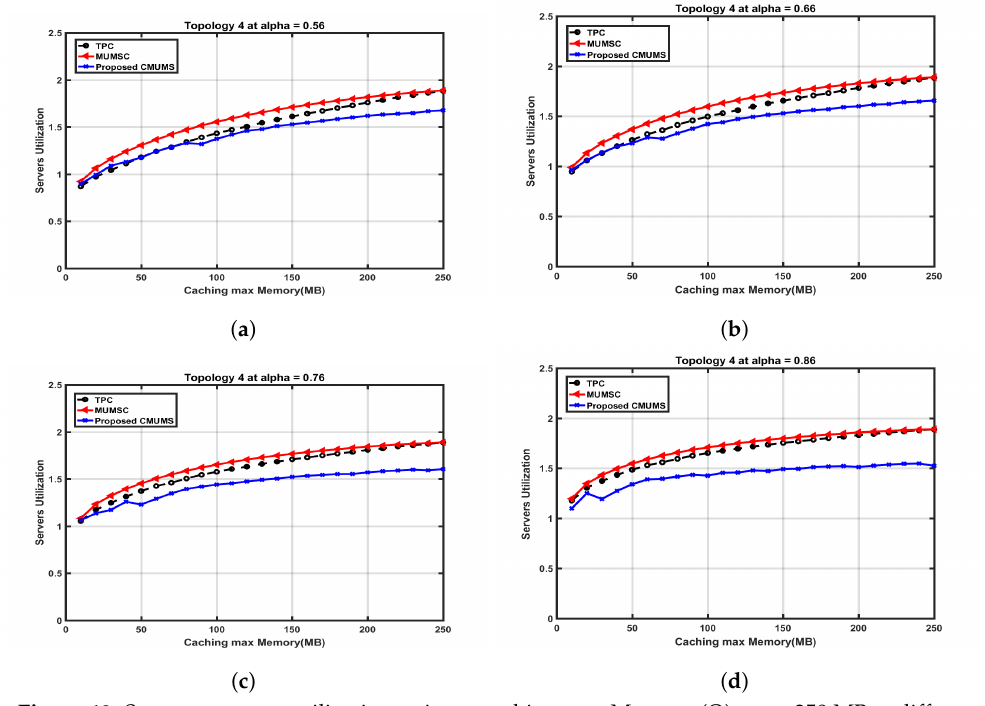
Figure 13. Server processor utilization ratio vs. caching max Memory (Q) up to 250 MB at different α . ( a ) Server utilization ratio vs. Q (at α = 0.56 as per [21]); ( b ) Server utilization ratio vs. Q at α = 0.66; ( c ) Server utilization ratio vs. Q at α = 0.76; ( d ) Server utilization ratio vs. Q at α =